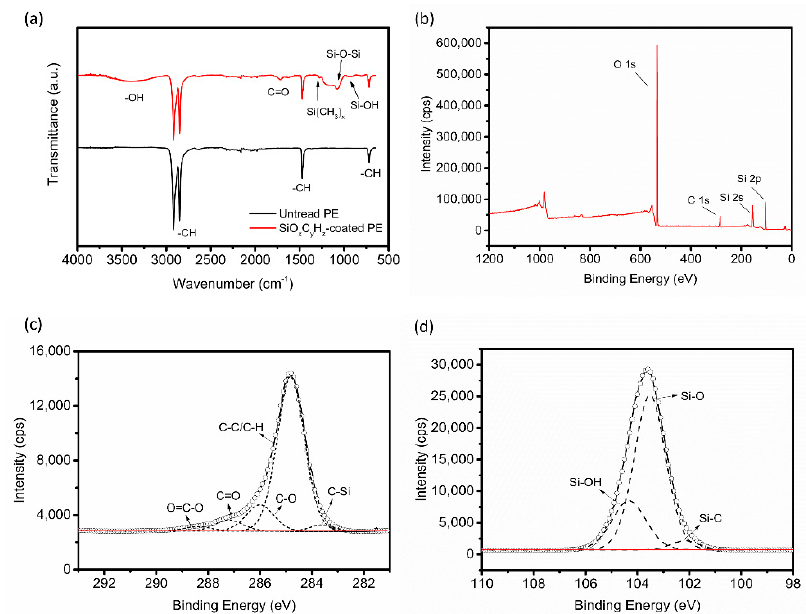
Figure 2. ( a ) Attenuated total reflection Fourier transform infrared spectroscopy (ATR-FTIR) spectra before and after plasma coating; ( b ) x-ray photoelectron spectroscopy (XPS) spectrum for the SiO x C y H z nanoparticulate film; ( c ) C 1 s spectra; ( d ) Si 2 p spectra.